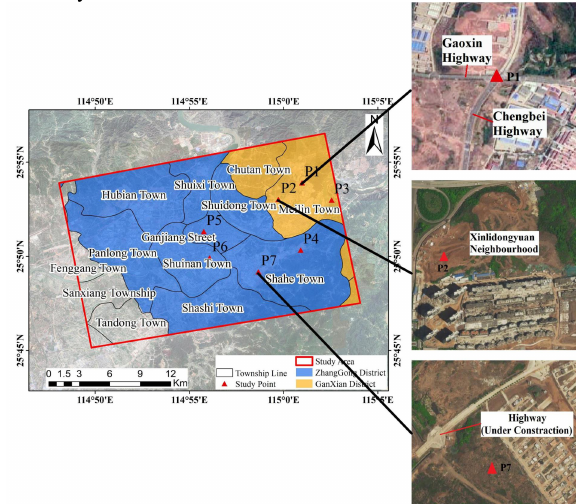
Figure 9. Satellite images around P1, P2, and P7 and the place of study points